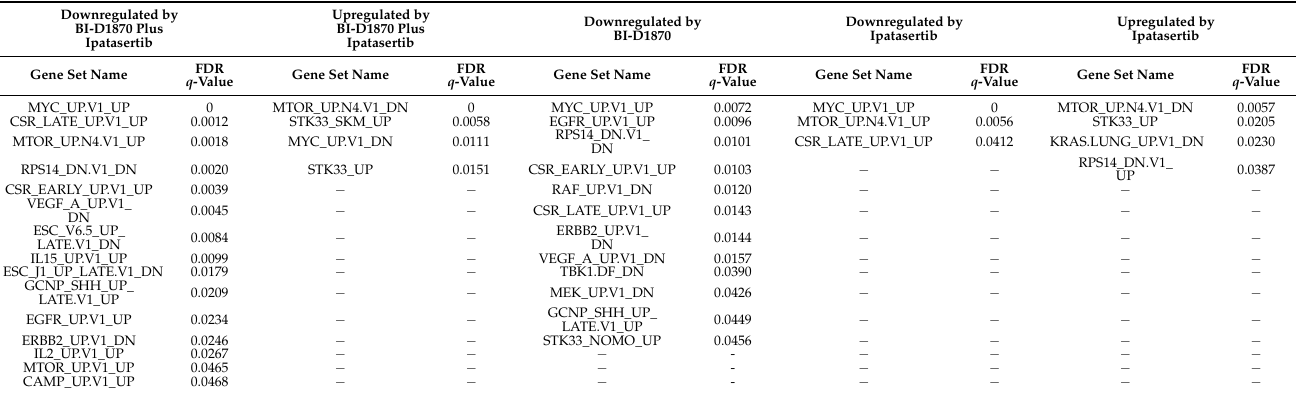
Table 2. Significantly modulated common gene sets by either BI-D1870, ipatasertib or the combination of BI-D1870 and ipatasertib in NCI-H929 and OPM-2 cells.